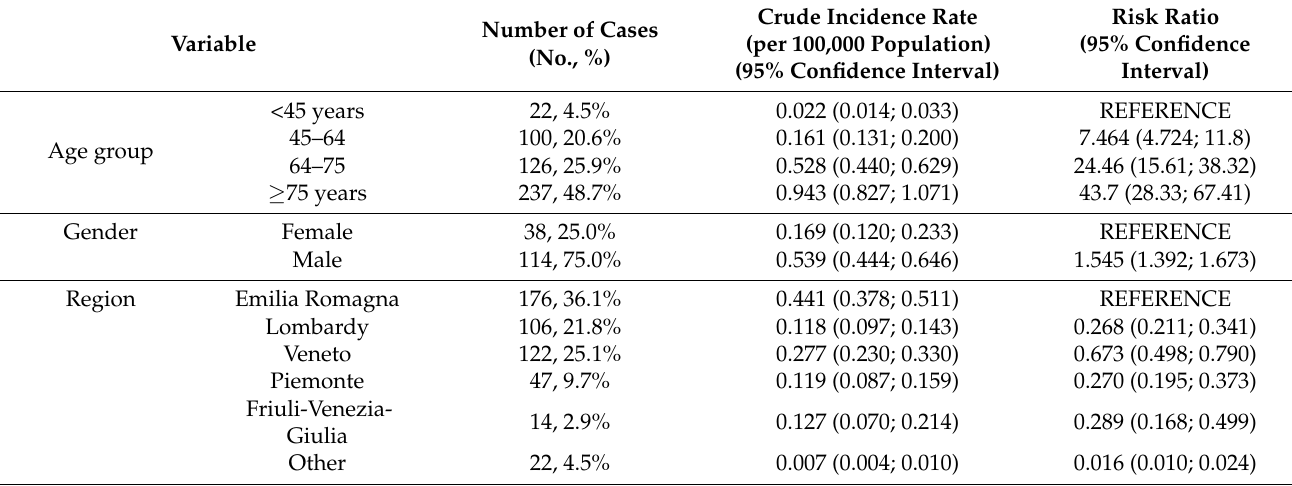
Table 4. Distribution of Italian West Nile neuro-invasive disease cases in Italy by region of residence and age group (2012–2020; No. = 487) and sex (2012–2016; No. = 152). A total of 485 out of 487 notified cases were included in the analyses as for 2 cases age at diagnosis was not available. For the calculation of risk ratio, age groups 0–14 and 15–44 year-old were collapsed in a single reference group.